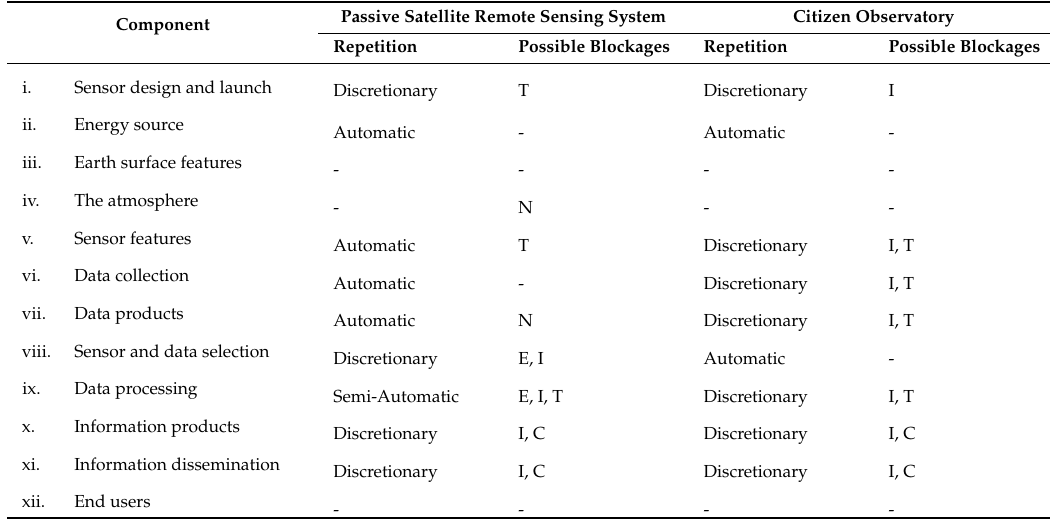
Table 5. Sources of repetitive functioning in a remote sensing system for monitoring tropical forest area change and a citizen tree observatory, showing possible blockages for communication (C), economic (E), institutional (I), natural (N) and technological (T) reasons. Component Passive Satellite Remote Sensing System Citizen Observatory Repetition Possible Blockages Repetition Possible